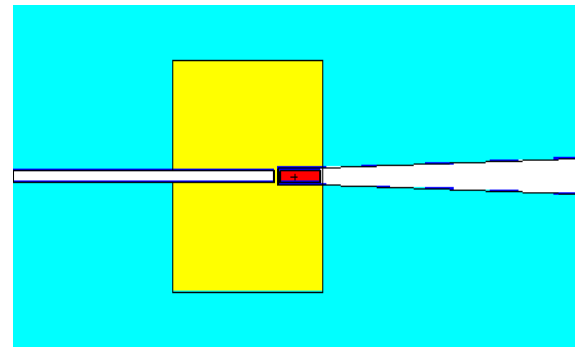
Fig. 1 . Proposed CNS for simulation study.